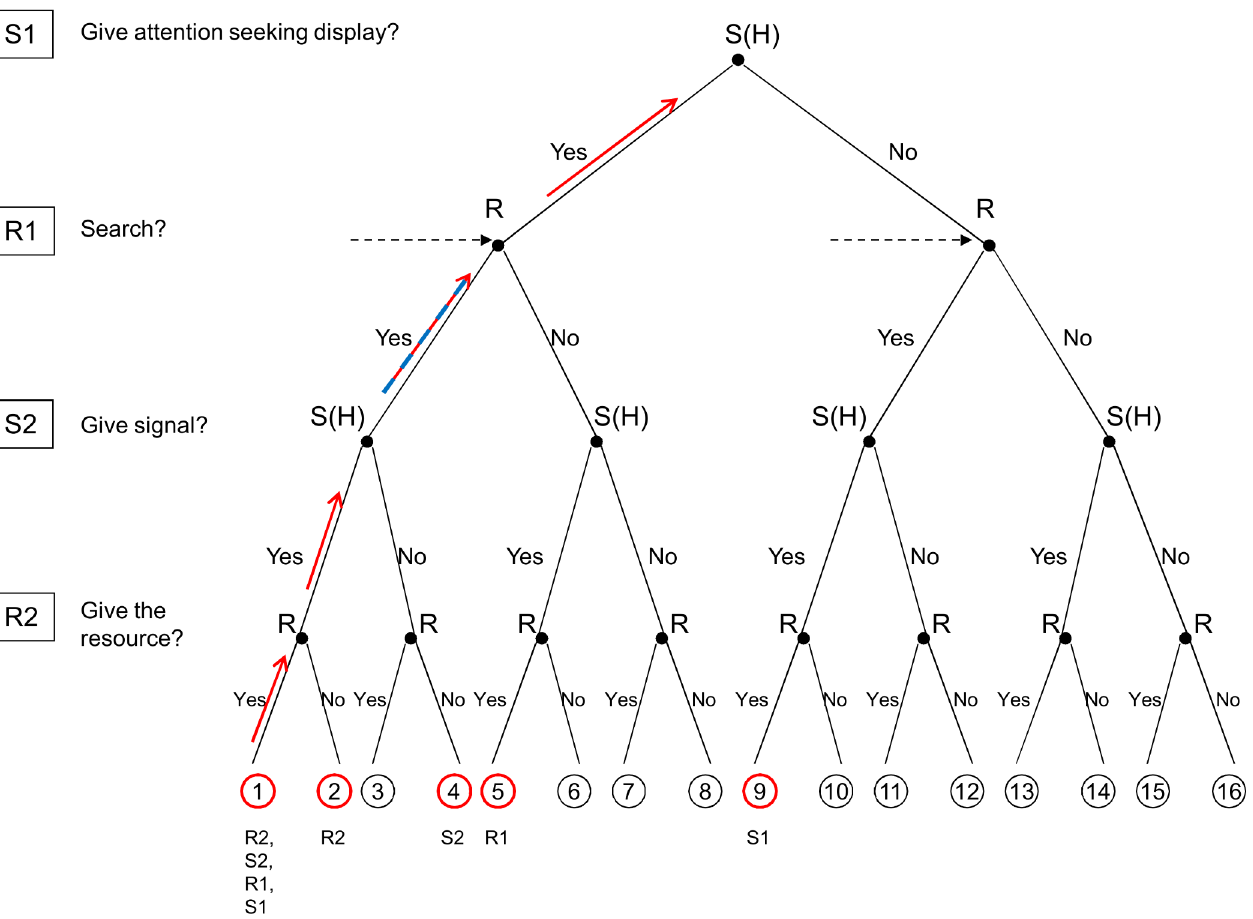
Fig 2. The logic of backward induction for high quality signallers. Arrows show the progression, coloured circles show the compared nodes and the label(s) below the circles show the step at which the given nodes are compared. We are searching for a pair of ESS strategies that lead to node 1 in case of the high quality signaller (i.e. where receivers search and high quality signallers give ASD). First step: node 1 vs. node 2 from the receiver ’ s point of view (R2). Second step: node 1 vs. node 4 from the signaller ’ s point of view (S2; note, since we are interested in the stability of the receiver's strategy of playing (U, D), strategy node 3 does not need to be considered). Third step: nodes 1 and 5 vs. nodes 12 and 16 weighted by the ratio of high to low quality individuals from the receiver ’ s point of view (R1; the reason behind comparing several nodes is the informational uncertainty the receiver facing at this point). Fourth step: node 1 vs. node 9 from the signaller ’ s point of view